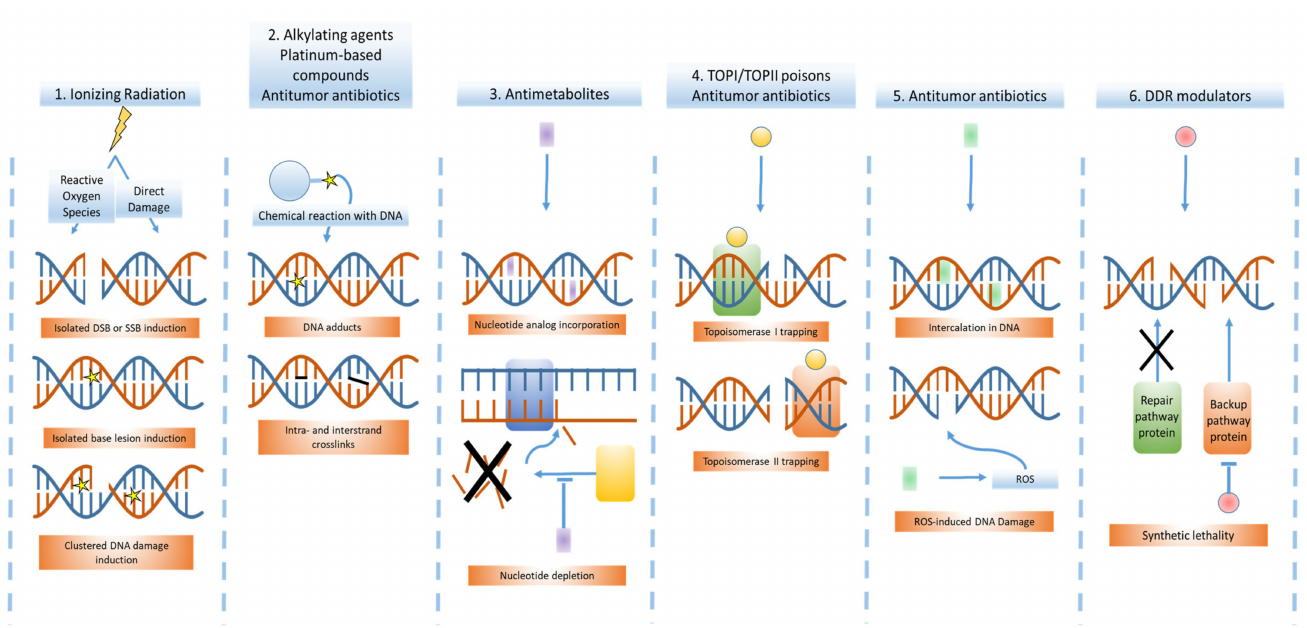
Figure 4. Visualization of the DNA-targeted mechanisms of action of radiotherapy, cytotoxic chemotherapy and DDR modulators. 1. Ionizing radiation (IR) can induce DNA damage both directly and indirectly (through ROS formation), leading to formation of SSBs, DSBs and di ff erent base lesions. Depending on the radiation type used, clustered (complex) DNA damage might be induced when multiple DNA lesions are formed in close vicinity. 2. Alkylating and platinum-based compounds harbor a reactive site and directly react with the DNA molecule., forming DNA adducts and intra- or interstrand crosslinks. 3. Antimetabolites mimic molecules essential in DNA replication and repair and, depending on the specific compound, can be incorporated in the DNA leading to DNA damage. Alternatively. antimetabolites can inhibit nucleotide producing pathways. 4. TOPI- and TOPII-poisons, the most clinically relevant topoisomerase inhibitors, trap topoisomerases on the DNA, preventing re-ligation of topoisomerase-induced breaks. For TOP1 poisons, DSBs are formed when DNA polymerase stalls on this trapped complex. However, for TOPII-poisons, trapping leads to the persistence of topoisomerase-induced DSBs. 5. Antitumor antibiotics can have di ff erent DNA-targeted mechanisms of action, such as compound intercalation in the DNA and induction of ROS formation. Other antitumor antibiotic mechanisms of action overlap with other cytotoxic chemotherapeutic classes, such as DNA alkylation and topoisomerase poisoning. 6. DDR modulators target specific DDR proteins and exert their cancer-inhibiting e ff ect by synthetic lethality: as cancer cells that have loss-of-function mutations in specific DDR pathways become more reliant on backup repair pathways, inhibition of the latter by DDR modulators can specifically target cancer cells versus healthy